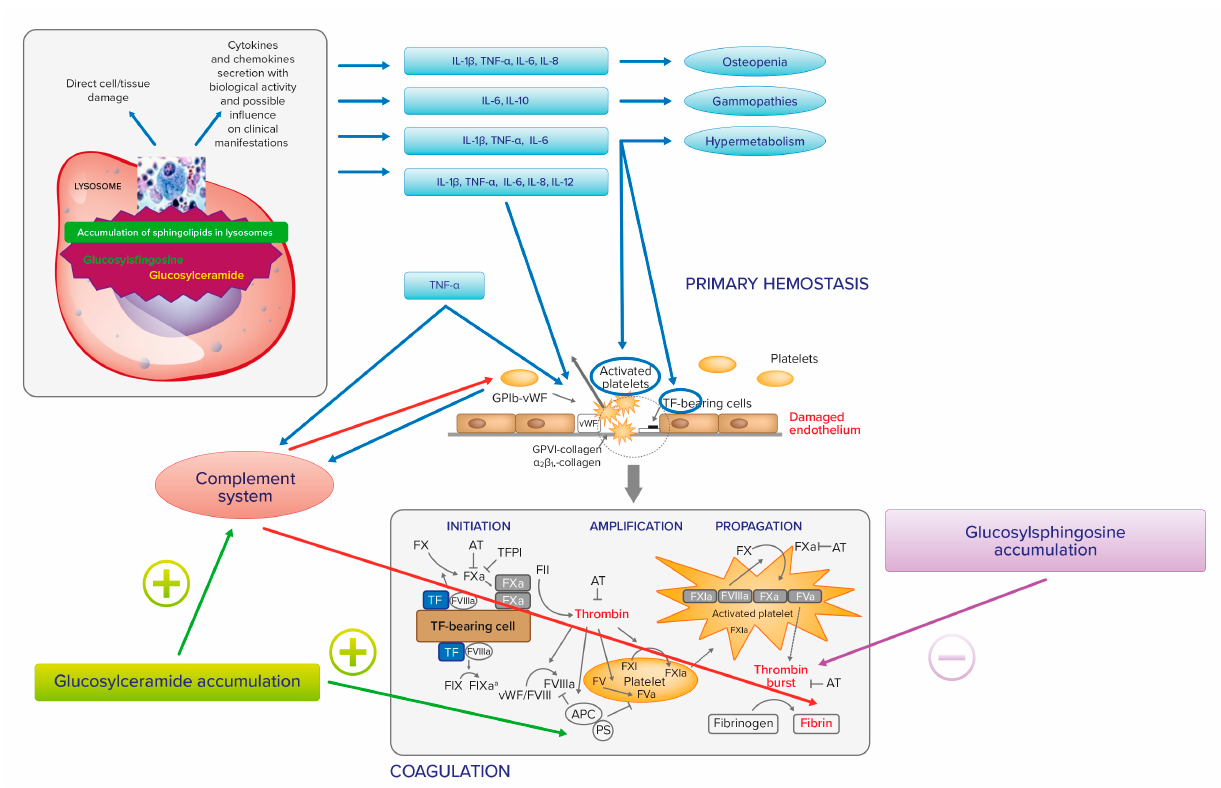
Figure 1. Relationship between Gaucher cell accumulation, proinflammatory cytokines, and hemo- stasis.